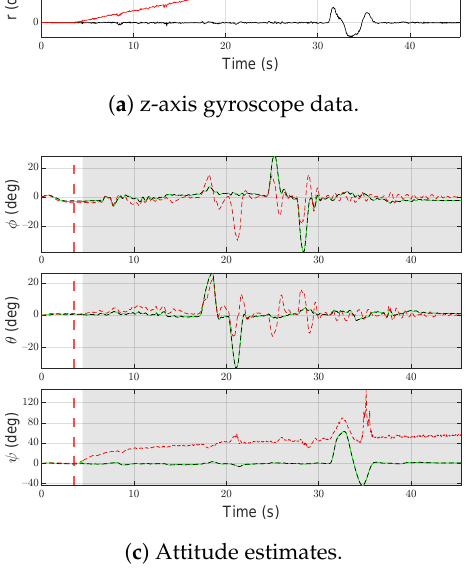
( a ) z-axis gyroscope data.